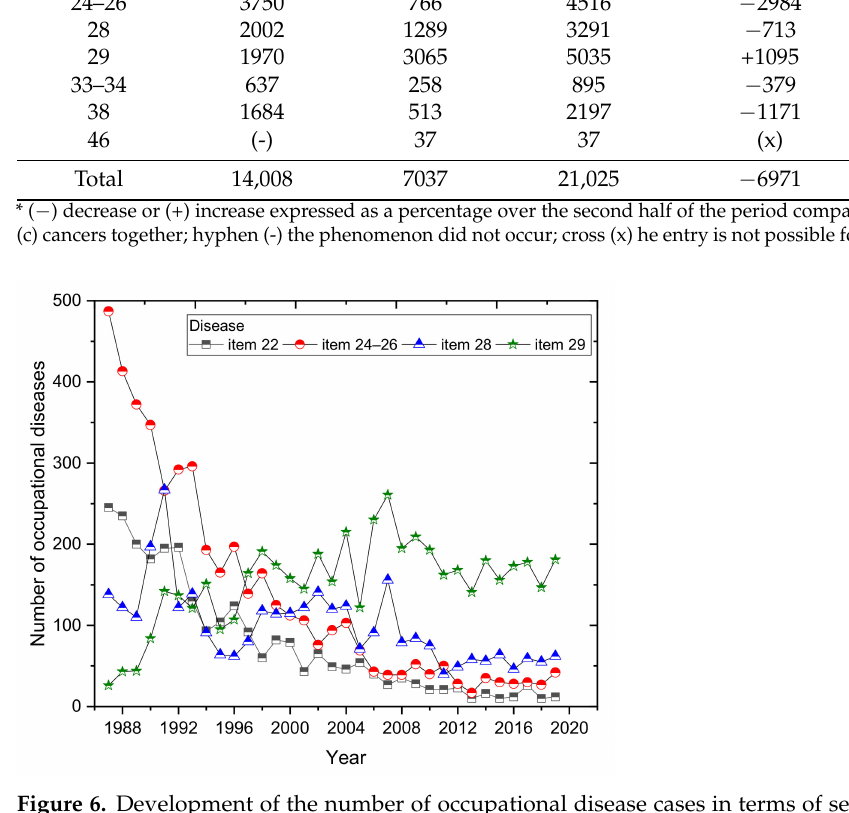
Figure 6. Development of the number of occupational disease cases in terms of selected types of disease